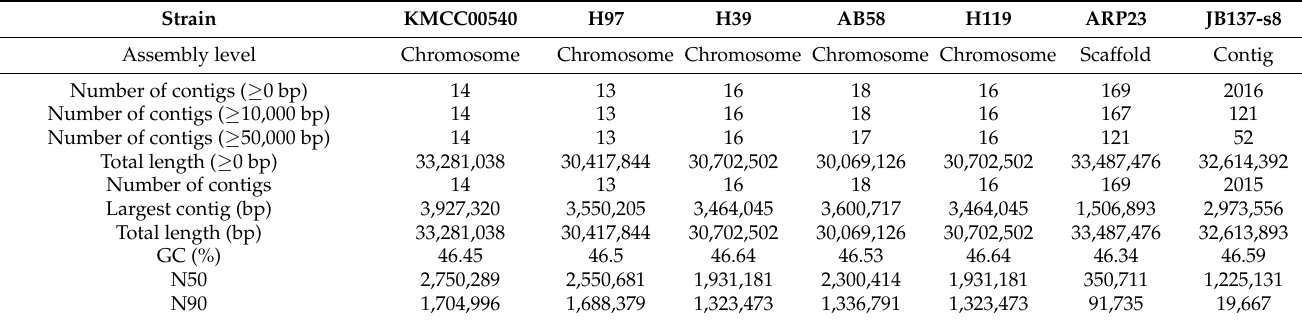
Table 1. Genome information comparison of A. bisporus